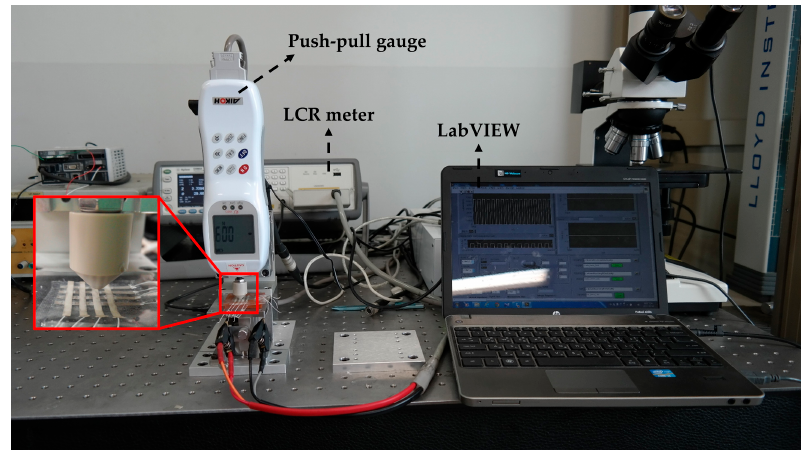
Figure 4. Experimental system.